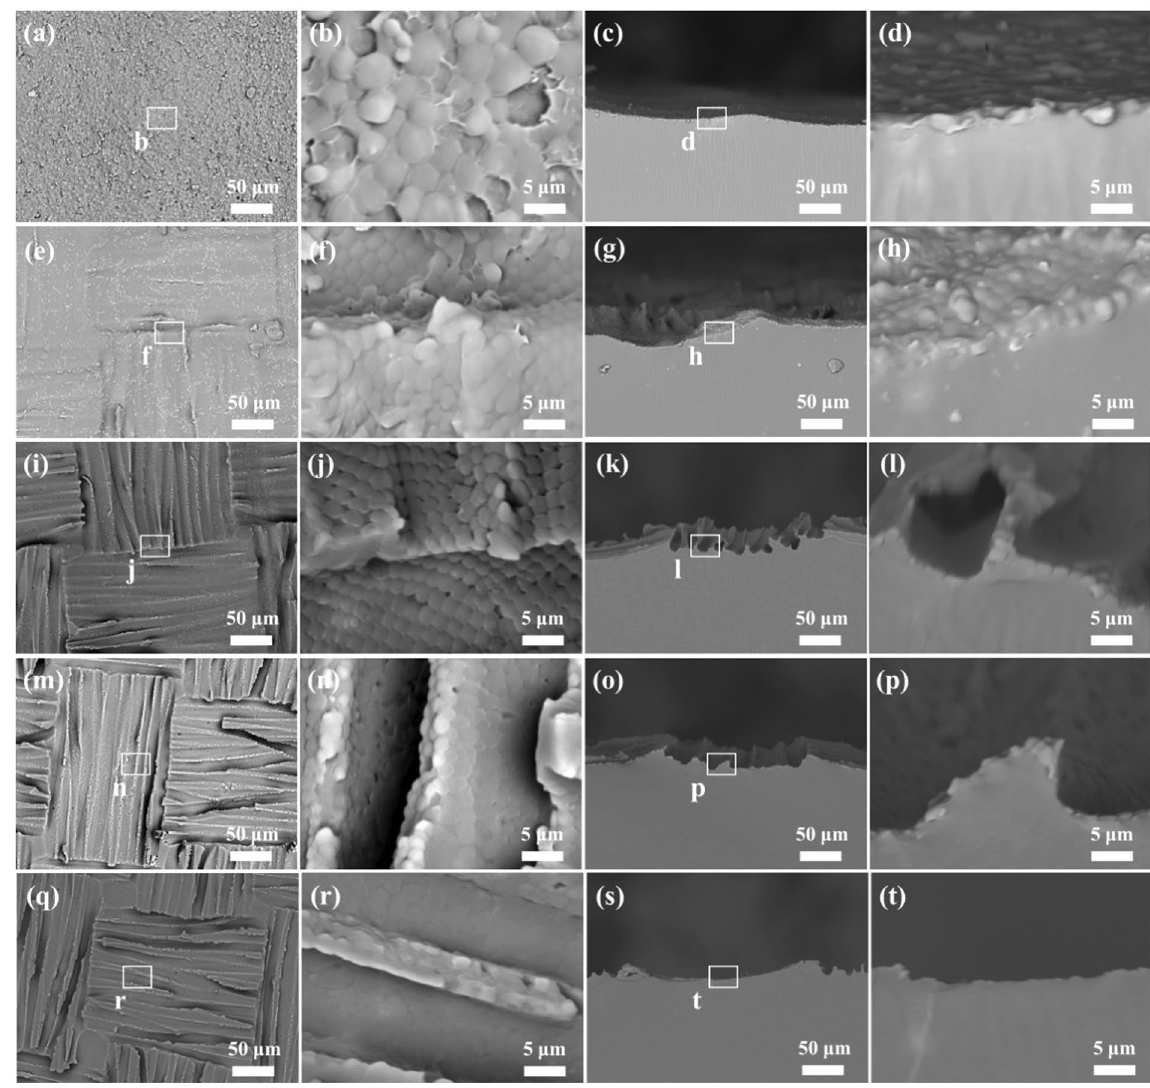
Figure 4. The positive PDMS replicas of CPMFs prepared from different solution concentration: ( a–d ) 60 mg, ( e–h ) 30 mg mL − 1 , ( i–l ) 15 mg mL − 1 , ( m–p ) 7.5 mg mL − 1 , and ( q–t ) 3.0 mg mL − 1 . The left and right two columns are the top views and cross-sectional views at different magnifications,